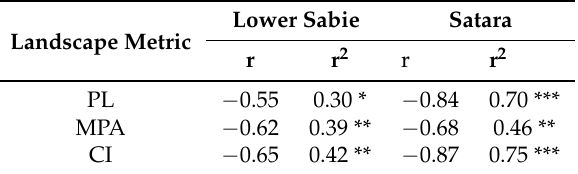
Figure 10. Plots of spatial metrics showing patterns in grazing lawn spatial structure and distribution with distance from water-points. CI = Cohesion Index, MPA = Maximum Patch Area, PL = Proportion of Landscape. Table 9. Pearson Correlations (r) and Coefficients of Determination (r 2 ) from the relationship between grazing lawn spatial metrics and distance from water source. PL = Proportion of Landscape, MPA = Maximum Patch Area and CI = Cohesion Index. Relationships are significant at p < 0.0001 ‘***’, p < 0.001 ‘**’ and p < 0.01